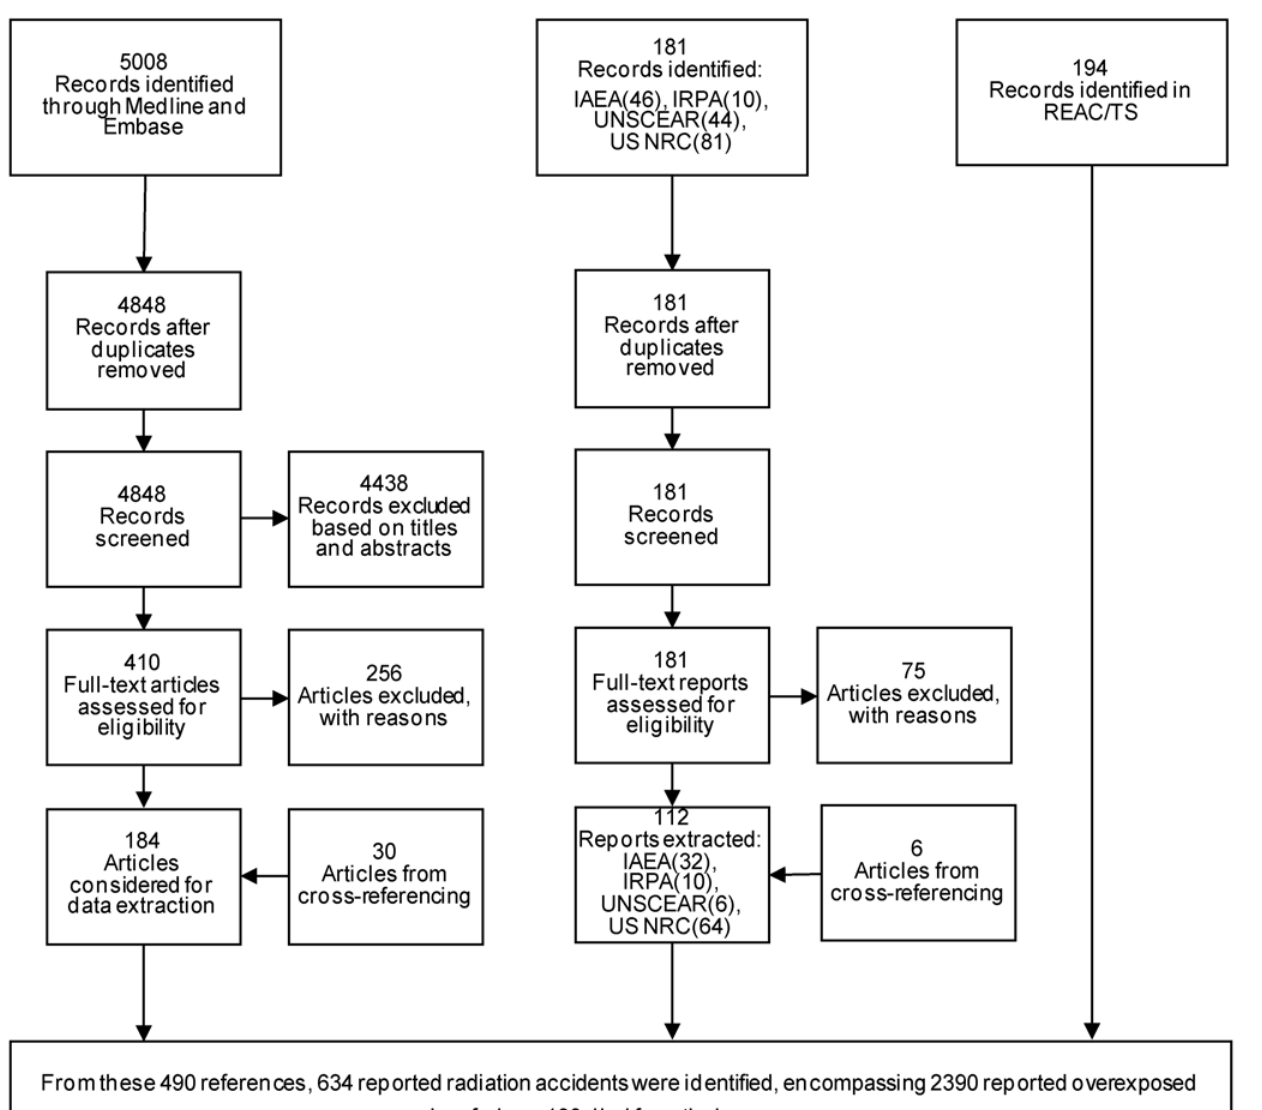
Fig 1. PRISMA flow chart. Search strategy for retrieving reported radiation overexposure accidents worldwide, 1980 – 2013.